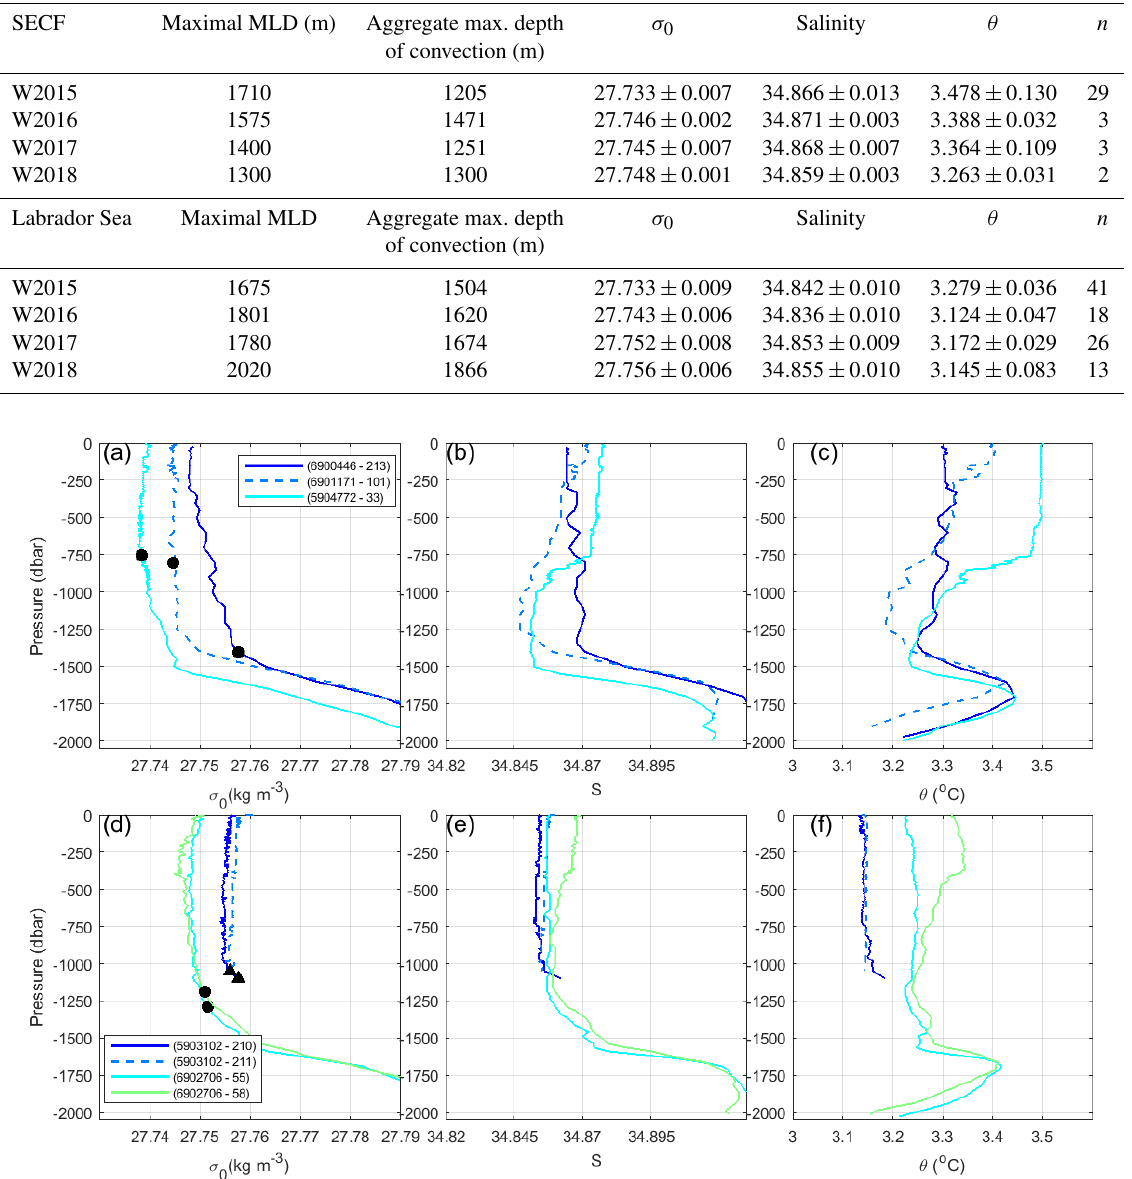
Figure 2. Vertical distribution of σ 0 , S and θ of Argo profiles showing an MLD deeper than 700m SECF in winter 2017 (a, b, c) and in winter 2018 (d, e, f) . The black points indicate the MLD. The triangles in (d) are the MLD that coincided with the maximal profiling pressure reached by the float. In the legend, the float and cycle of each profile are